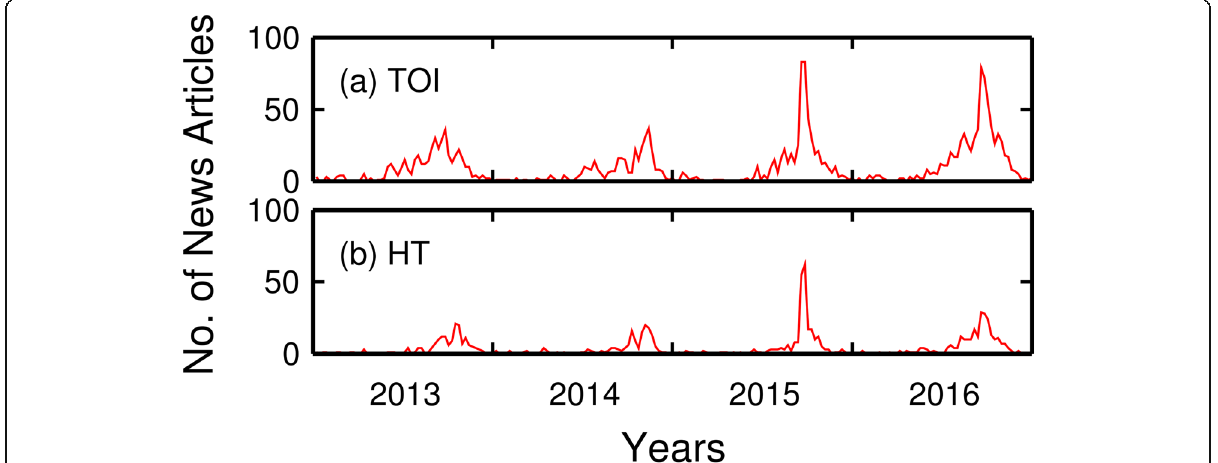
Fig. 1 The time variation in the number of weekly news reports from Indian local news outlets from 2013 to 2016. a TOI and b HT